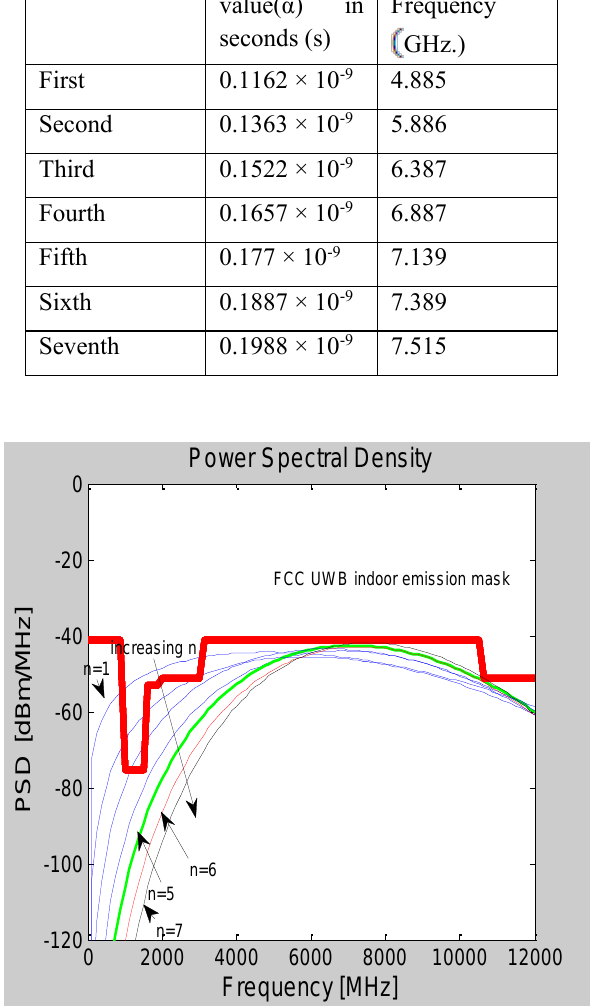
Fig.6. Power Spectral density of the Gaussian derivatives for obtained pulse shape